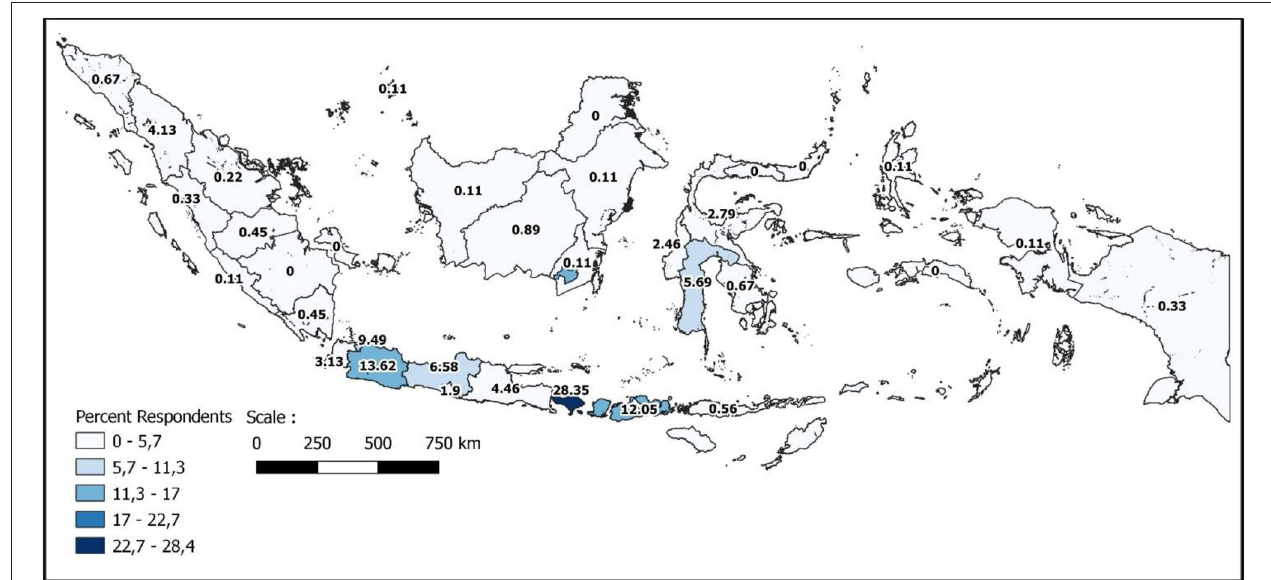
FIGURE 1 | Geographical distribution of